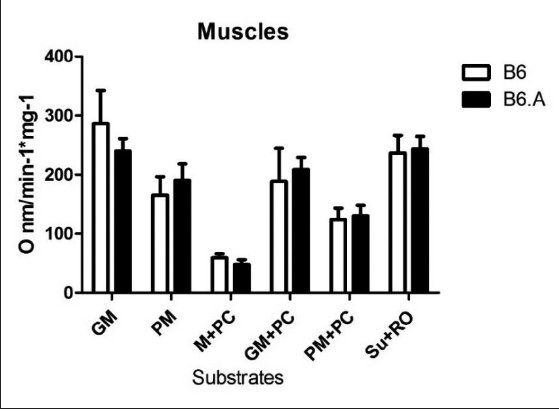
Su + RO – succinate plus rotenone.